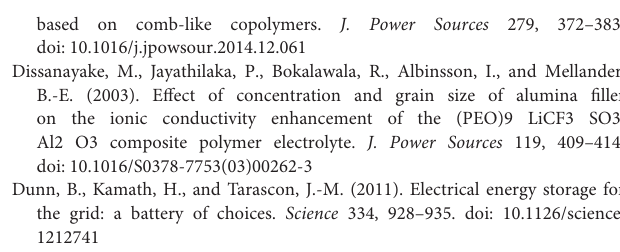
great potential application in high-performance LIBs at elevated